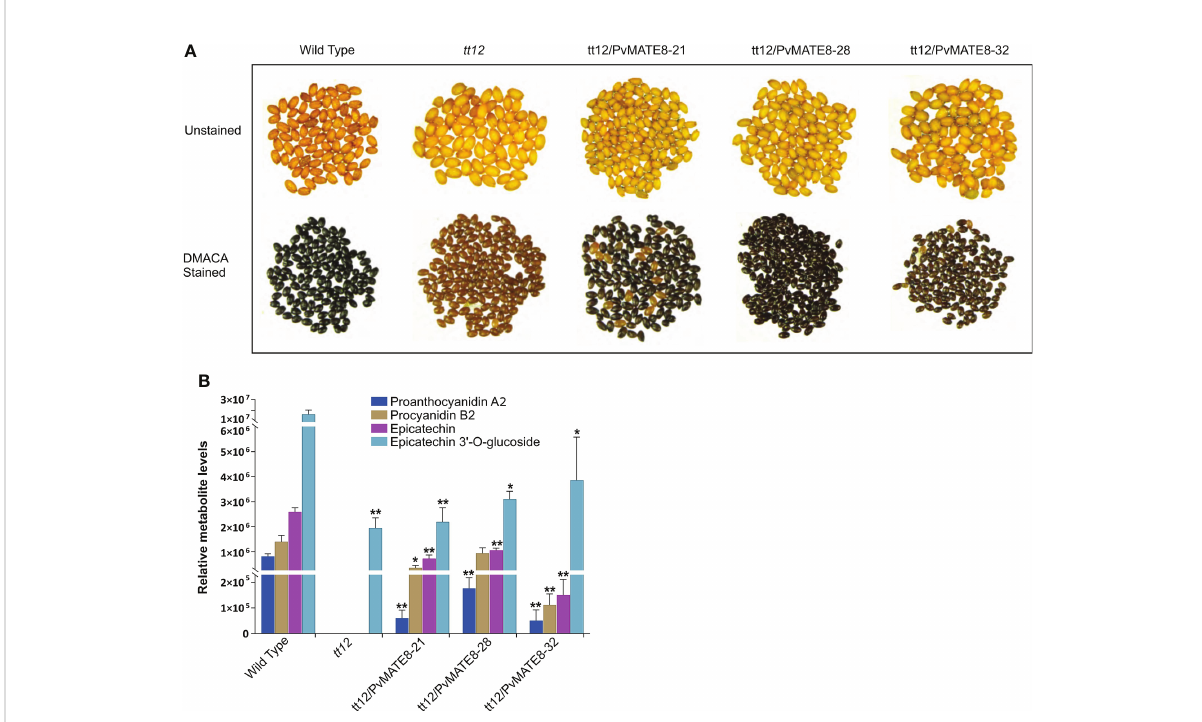
FIGURE 9 Genetic complementation of tt12 by PvMATE8 restores PA in Arabidopsis. (A) Unstained (top panel) and DMACA stained (bottom panel) seeds of wild type (Ws-2 ecotype), tt12 , and three T2 complementation lines overexpressing PvMATE8-21, PvMATE8-28, PvMATE8-32 are shown. (B) LC- MS analysis to identify four target metabolites in corresponding Arabidopsis seeds, shown in Figure 9A. Each bar represents the relative abundance calculated from the peak area. Data are presented in SEM (n = 5). Signi fi cance was determined by one-way ANOVA (Dunnett ’ s post hoc test, alpha =0.05), *p<0.001, **p<0.00001 indicates a signi fi cant difference in relative abundance on each metabolite from the wild type.